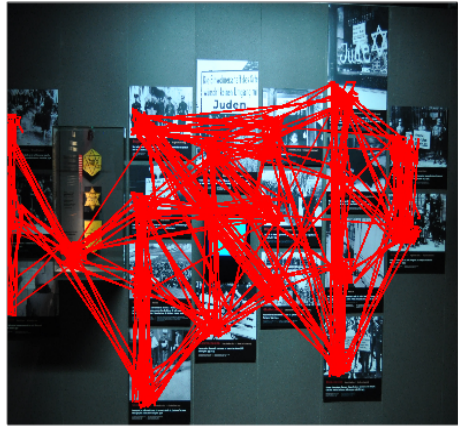
Figure 6. Mapping of all the trajectories of the 17 partici- pants going through the wall of photographs in zone 2, made up of 19